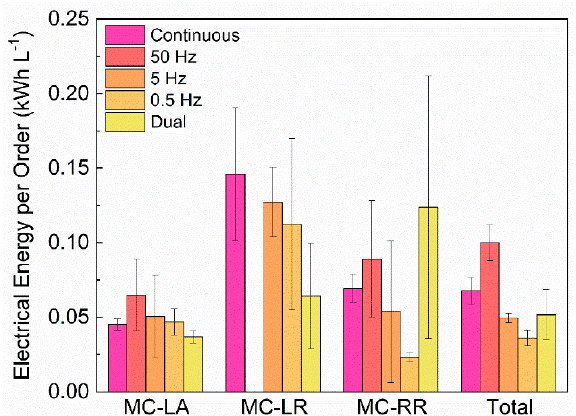
Figure 2. Electrical energy per order for microcystin degradation under continuous and controlled periodic illumination (CPI) conditions.